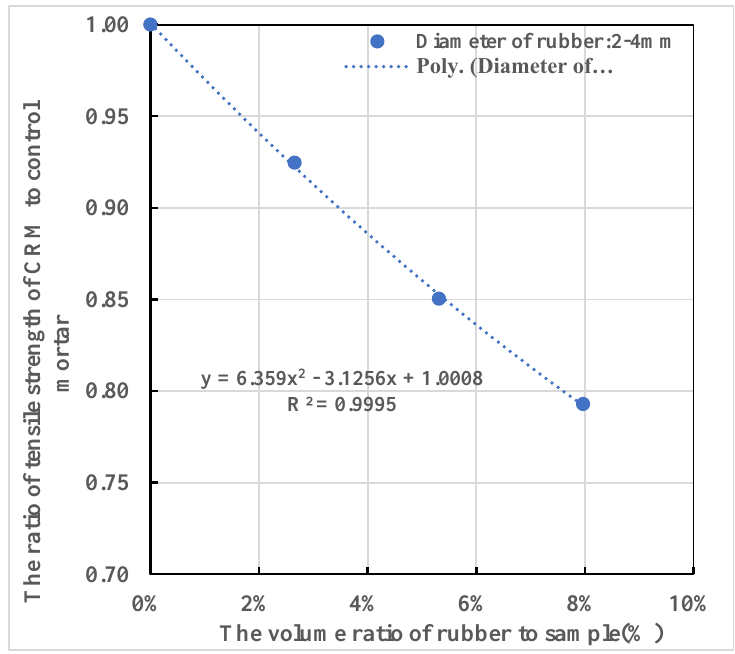
Figure 20. The best-fitting curve of indirect tensile strength and rubber content. Table 9. Increased porosity of the CRM caused by the use of rubber particles. The Volume Ratio of